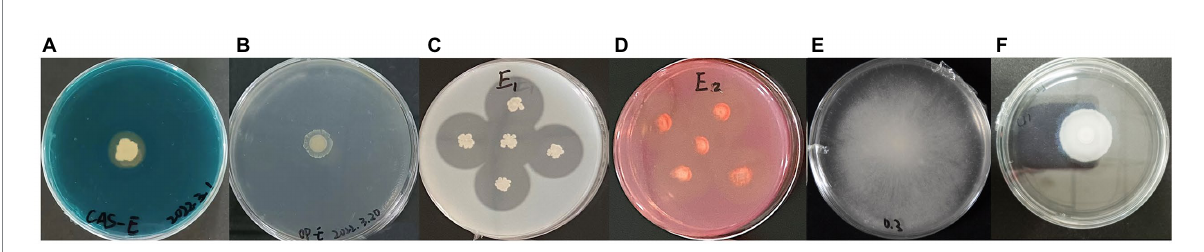
FIGURE 6 Plant growth promoting and environmental fitting traits of strain E. (A) Siderophore production. (B) Organic phosphate solubilization. (C) Protease production. (D) Cellulase production. (E) Swimming motility. (F) Swarming motility. All assays were performed in three or five repetitions in three independent experiments.